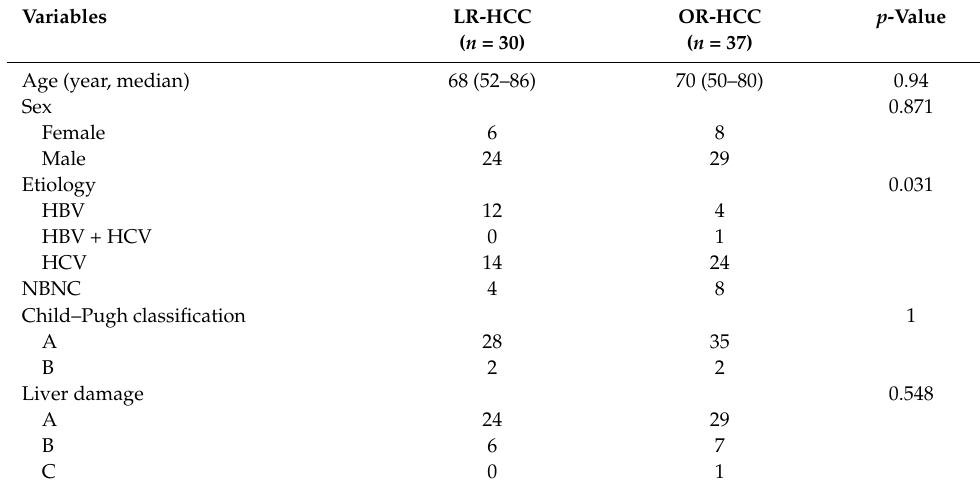
Figure 1. Survival analyses according to the previous treatment modalities. Kaplan–Meier curves for overall survival rates ( A ), recurrence-free survival rates ( B ), and disease-specific survival ( C ) of patients according to the previous treatment modalities. Survival rates in patients with previous locoregional therapy were significantly worse than those in patients with previous hepatectomy in the log–rank test. Hx, recurrence after hepatectomy; LTx, recurrence after locoregional therapy. Table 2. Patient characteristics stratified by the recurrence pattern after locoregional